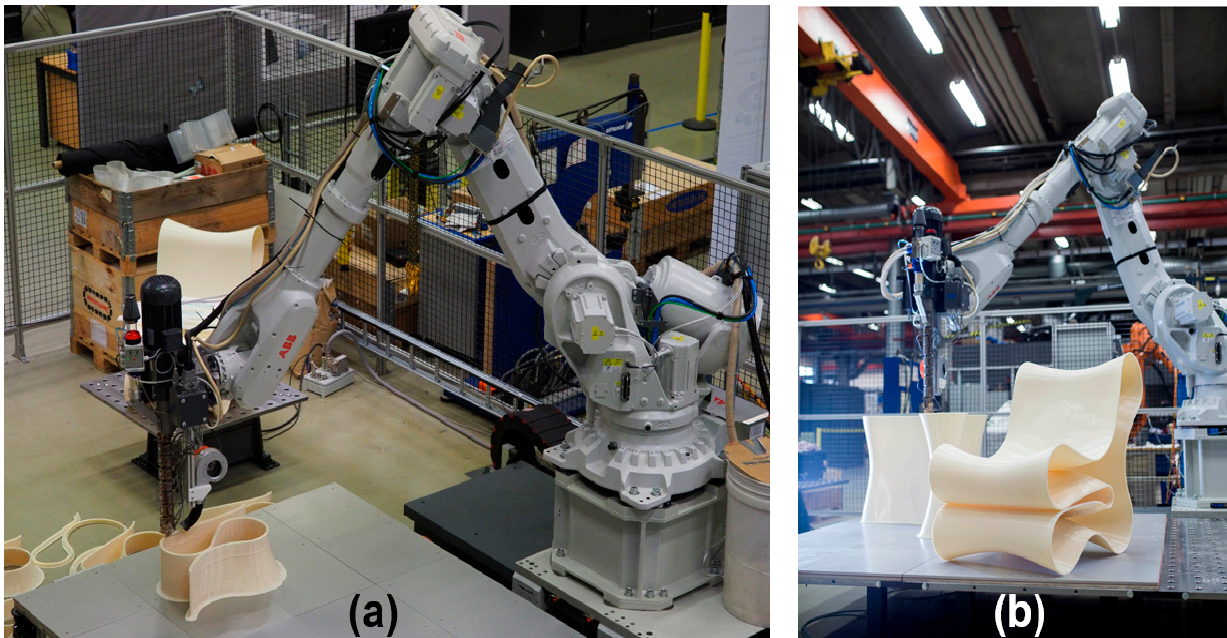
Figure 1. ( a ) IRBAM system setup printing a full-size chair from ABS. ( b ) Photograph of the